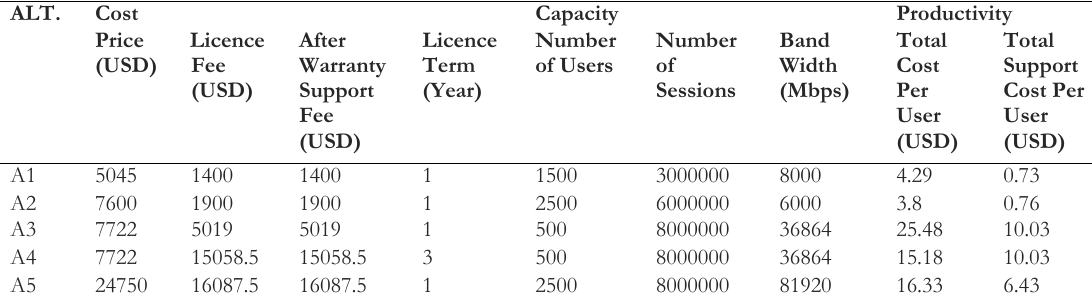
Table 1. Collected firewall alternatives from service